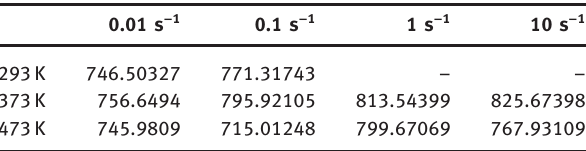
Table 12: f 2 ð _ ε , T Þ value under low temperature range with different strain rates.